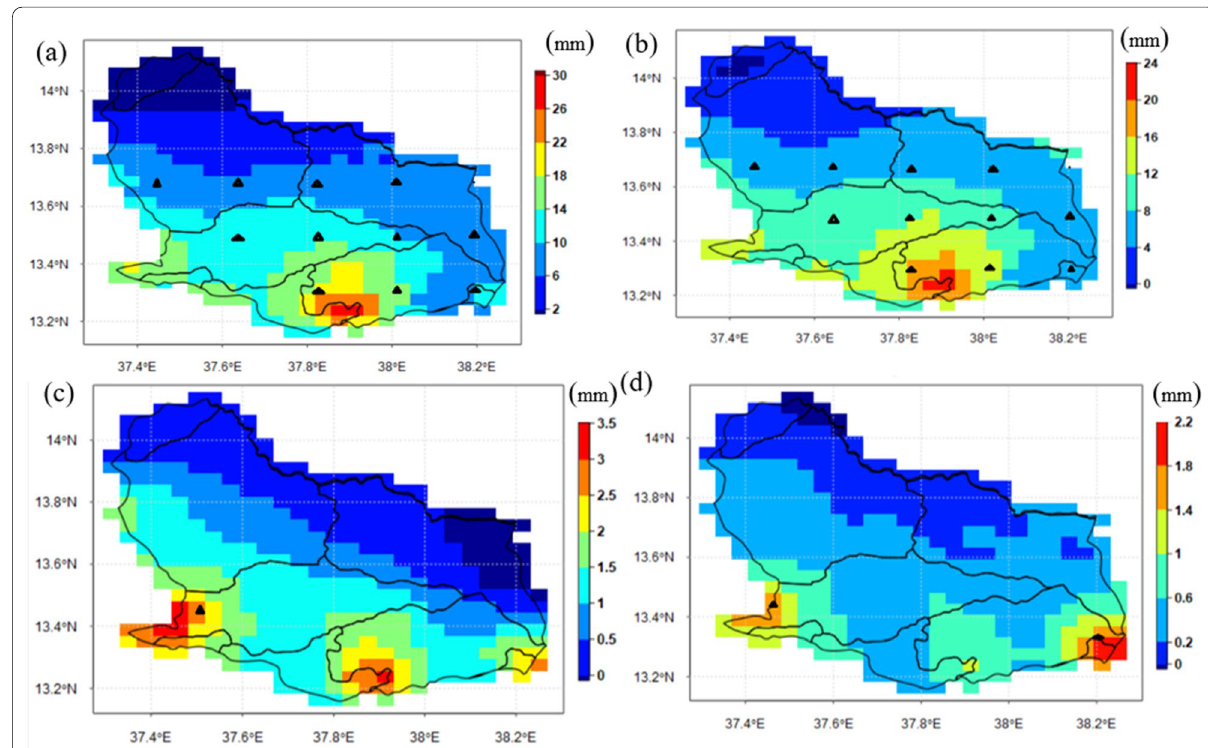
Fig. 9 Direction and magnitude of trend annual ( a ), Kiremit season ( b ), Belg season ( c ) and Bega season ( d ) rainfall ( grids that showed significant